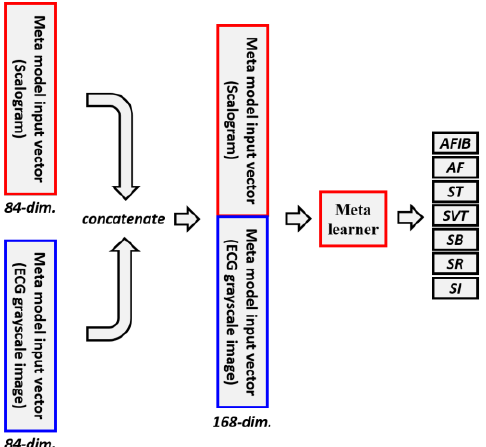
Figure 3. Architecture of multi-modal stacking ensemble. Multi-modal stacking ensemble combines output probabilities of 12 base learners that were trained with scalogram images and ECG grayscale images.